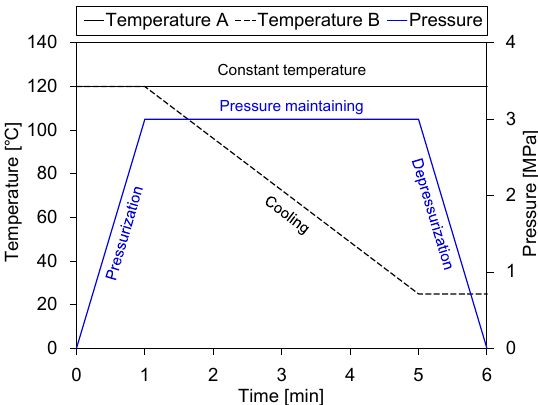
Figure 7. Thermomechanical loading cases considered in the gas-blow forming